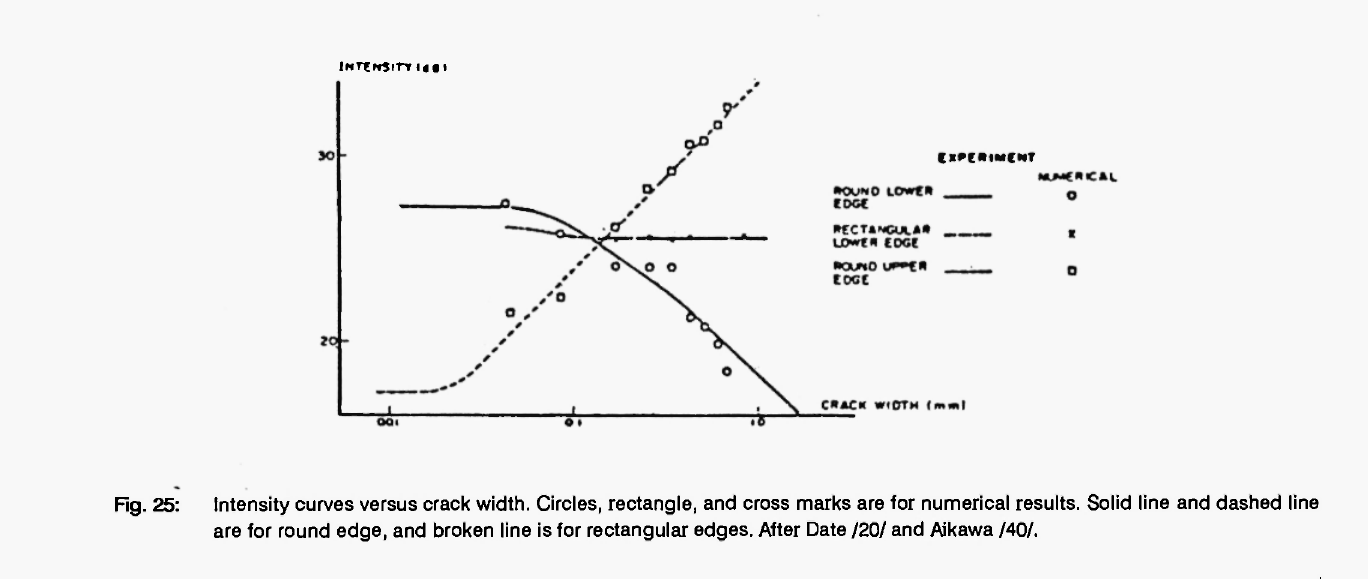
Fig. 25: Intensity curves versus crack width. Circles, rectangle, and cross marks are for numerical results. Solid line and dashed line are for round edge, and broken line is for rectangular edges. After Date 1201 and Aikawa /40/.